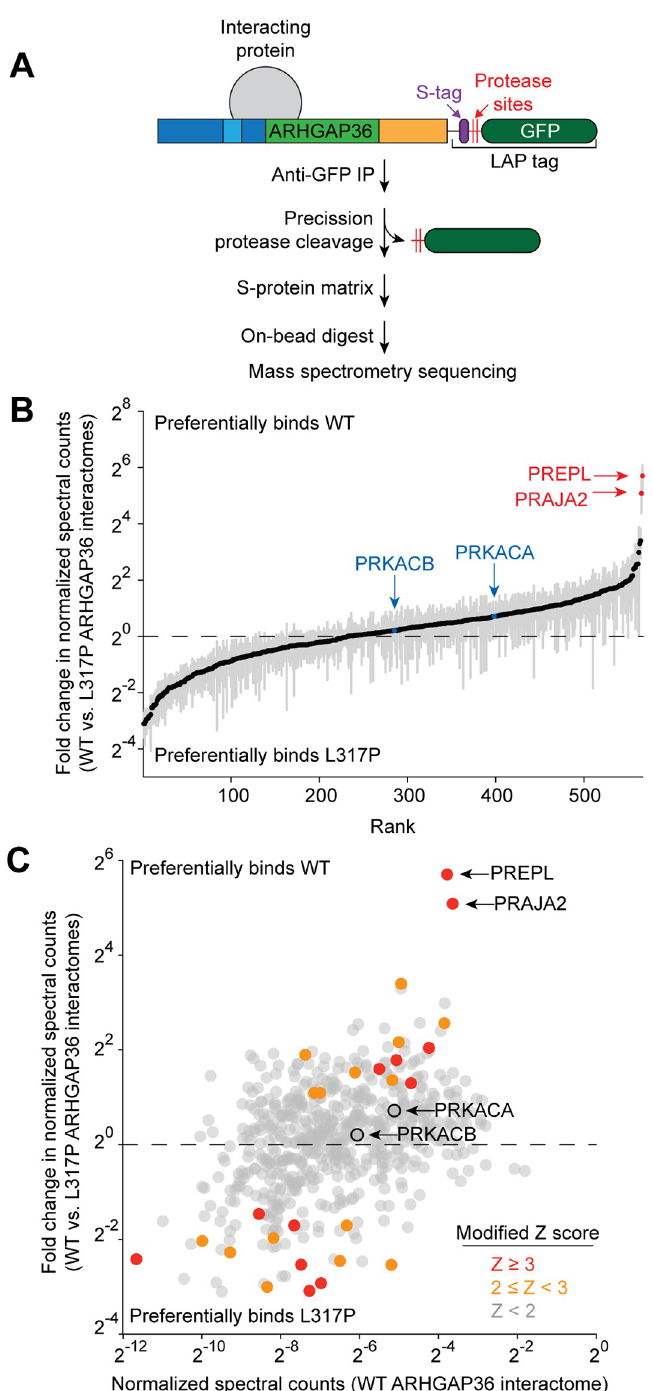
Fig 5. PREPL and PRAJA2 interact with ARHGAP36 in a GAP-like domain-dependent manner. (A) Schematic representation of the tandem affinity purification workflow for identifying ARHGAP36-binding proteins. (B) ARHGAP36 interactors ranked in order of their relative binding to the wild-type versus L317P proteins. Fold changes in normalized spectral counts represent the average values for three biological replicates ± s.e.m., shown as grey bars. (C) Scatter plot of ARHGAP36 isoform 2-binding proteins according to their normalized spectral counts in the wild- type and L317P interactomes. Each data point represents the average value for three biological replicates, and a modified Z-score was calculated for each fold change in abundance (see